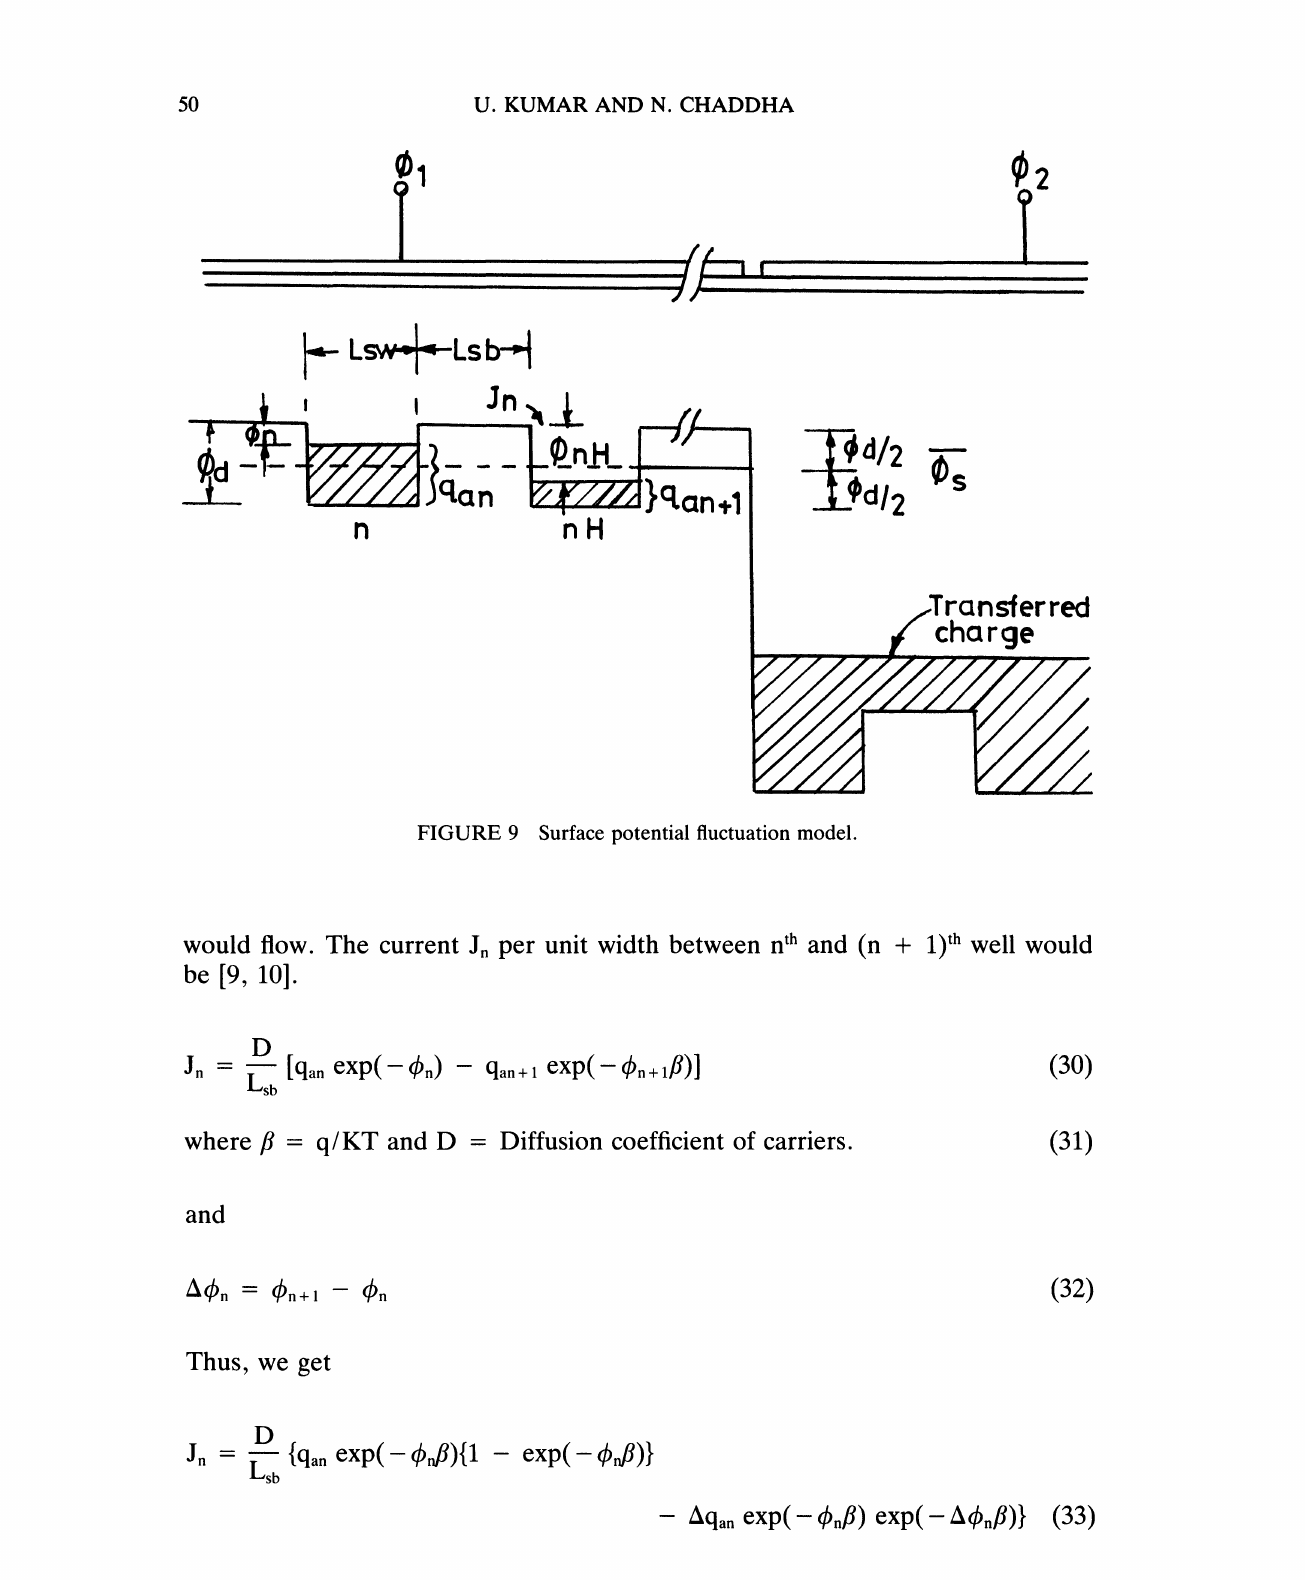
FIGURE 9 Surface potential fluctuation